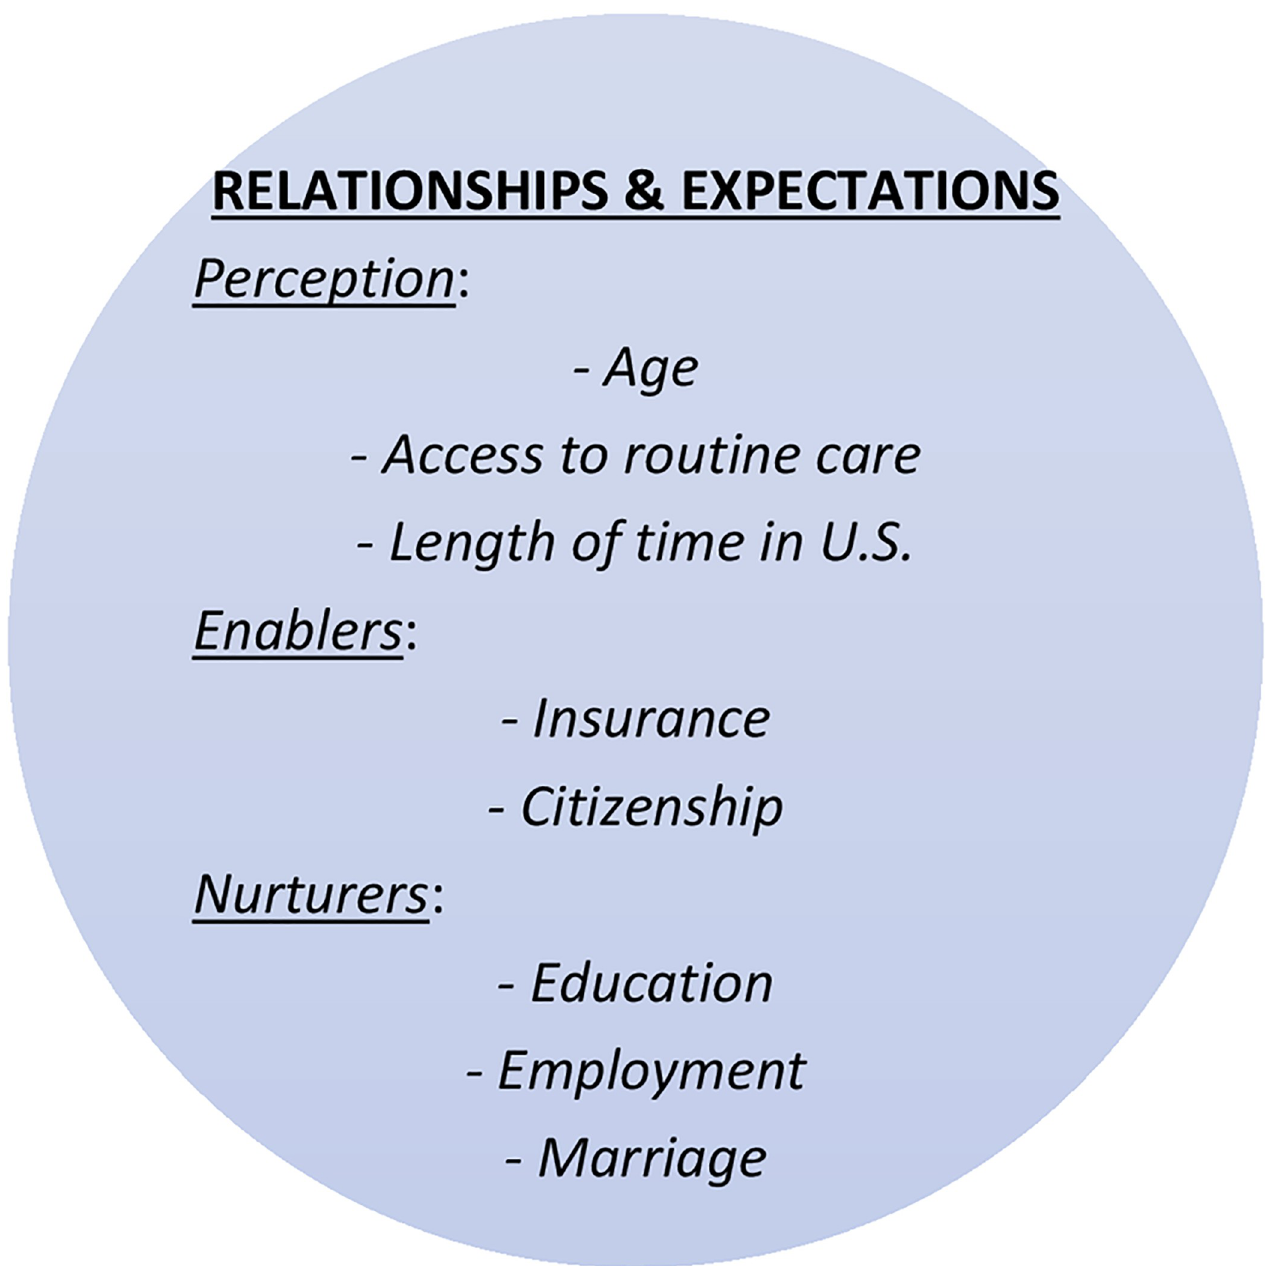
Fig 2. The PEN-3 Cultural Model relationships and expectations domain. Relationships and expectations of the PEN-3 Cultural Model were applied to theoretically organize the study variables.